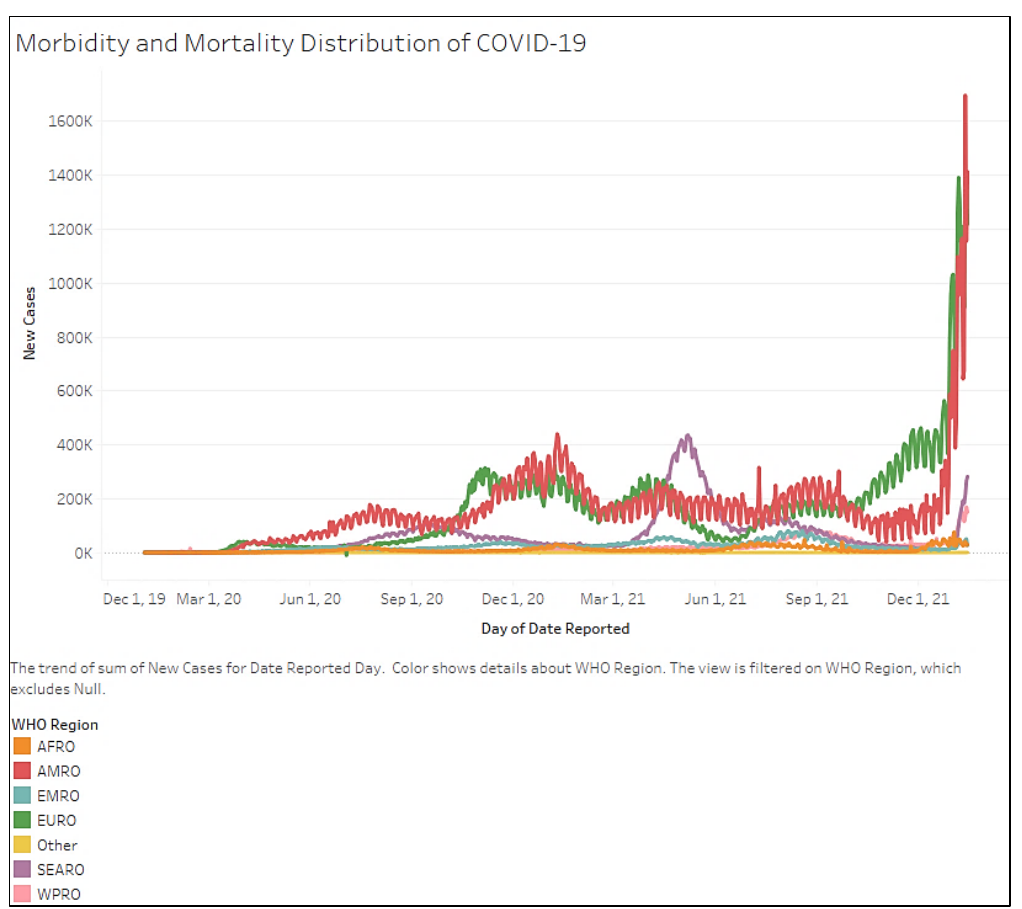
Figure 2. Global distribution of morbidity and mortality of SARS-CoV-2 based on the reported cases and